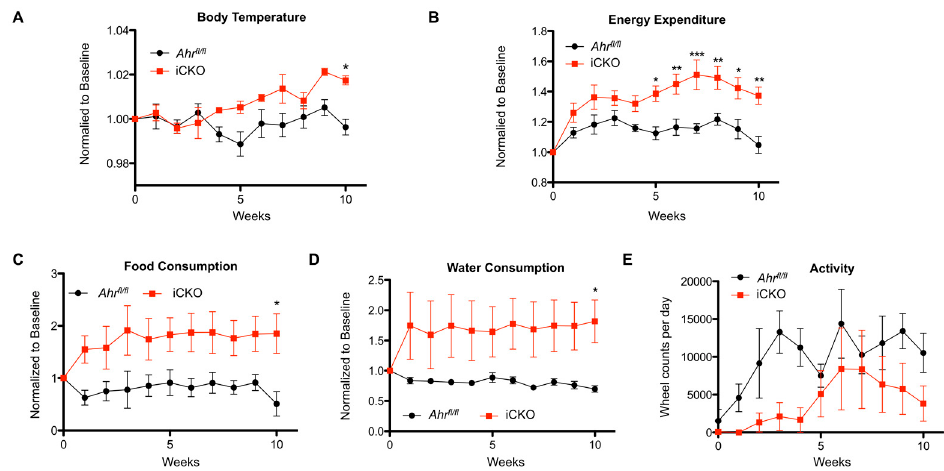
Figure 4. iCKO mice exhibit increased energy expenditure without an increase in physical